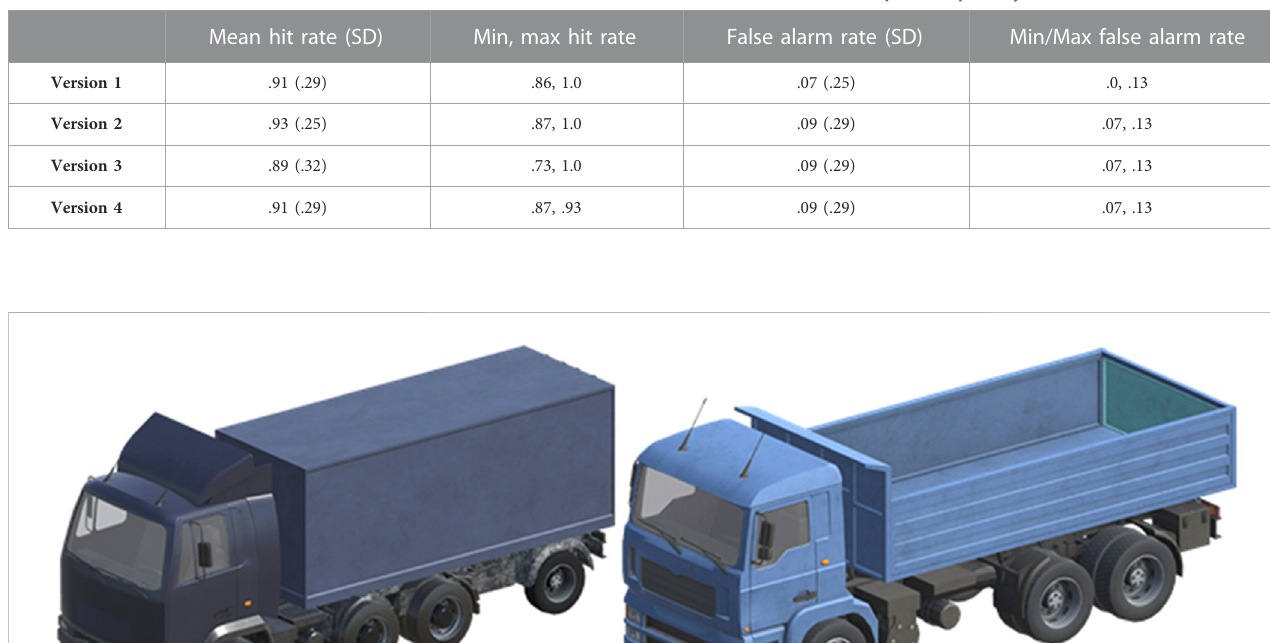
TABLE 1 Mean, standard deviation (SD), and minimum and maximum hit rate and false alarm rates for the RMT, reported separately for each of the four task versions.